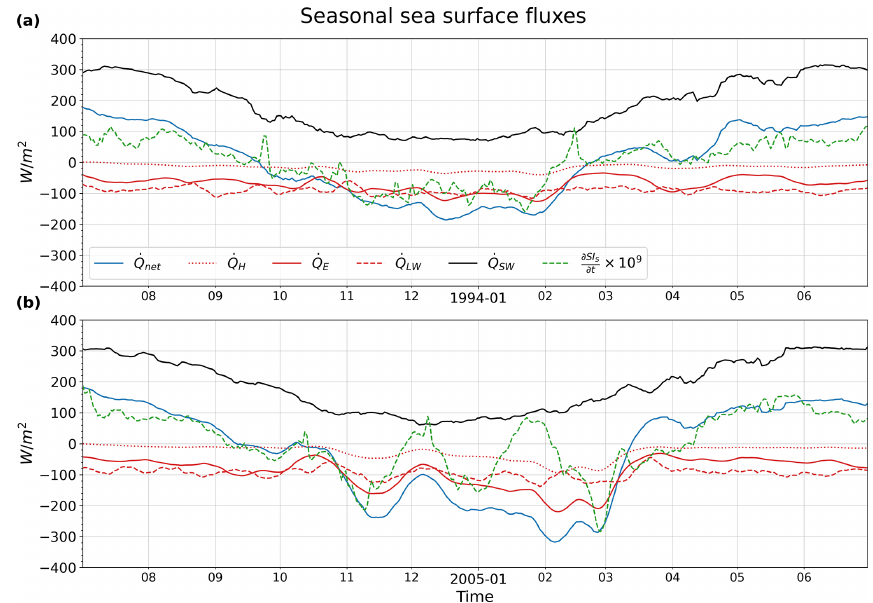
Figure 17. The smoothed seasonal sea surface fluxes spatially averaged over the 42 to 42.5 ◦ N and 4.25 to 5 ◦ E area, with the dashed green line denoting the estimated derivative w.r.t. time of the seasonal SI from the NEMO results, multiplied by 10 9 m 4 Js − 2 . A negative value means heat is leaving the